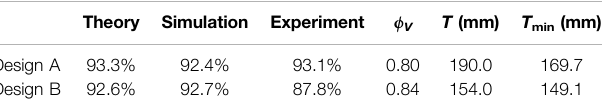
TABLE 3 | Comparison of the absorption performance between the non- optimized (design A) and the optimized (design B) absorber. “ Theory ” and “ Simulation ” refer to the average absorption coef fi cients over 50 – 63 Hz based on theanalyticalmodelandthe fi rsttypeofnumericalresult,while “ Experiment ” refers to the average absorption coef fi cient over 48 – 61 Hz based on the experimental result. ϕ V and T are the volume porosity and total thickness of thedesign. T min isthe minimumthickness dictatedbytheprincipleofcausality (i.e., Eq. 7